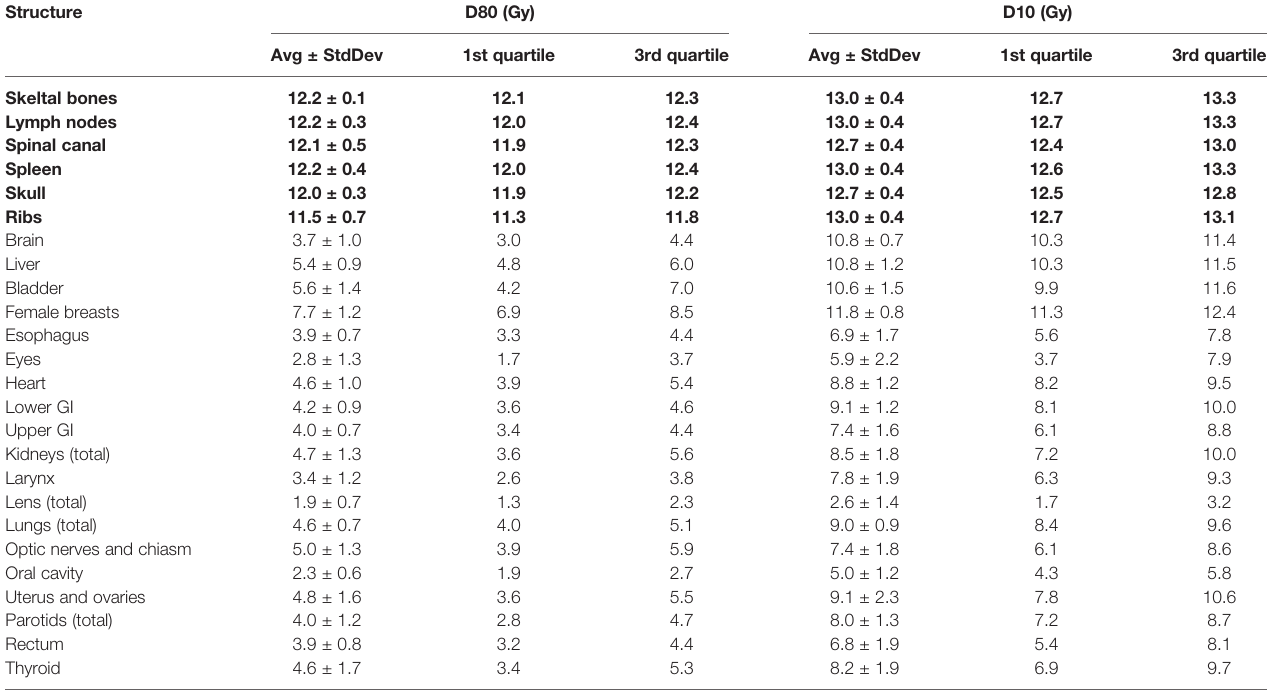
TABLE 3 | Statistics of D80 and D10 for each structure with the 12-Gy cohort. Structure D80 (Gy) D10 (Gy) Avg ± StdDev 1st quartile 3rd quartile Avg ± StdDev Skeltal bones